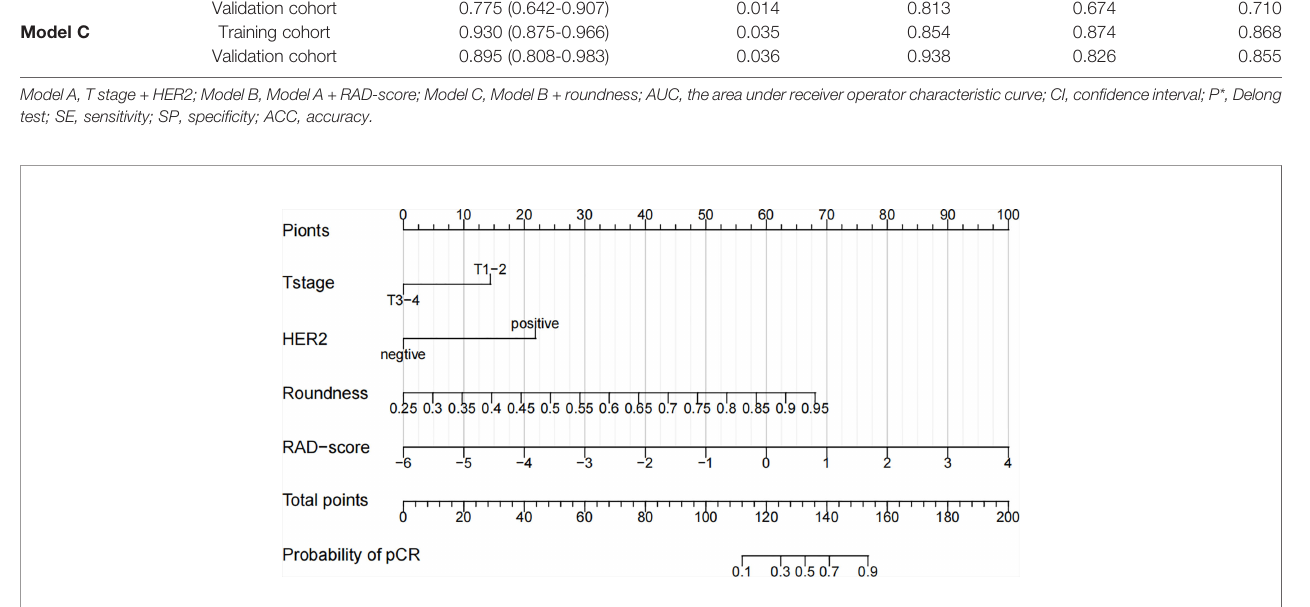
FIGURE 6 | A nomogram for the prediction of the pathological complete response of neoadjuvant chemotherapy in invasive breast carcinoma of no speci fi c